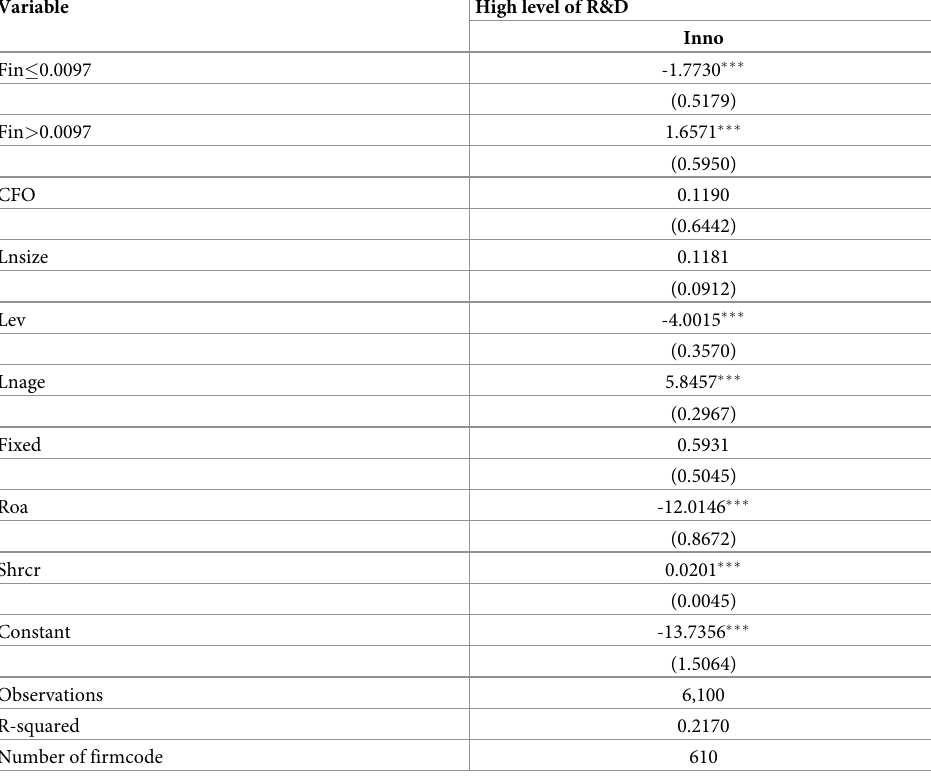
adopted to conduct parameter estimation in Table 6. Table 6. Regression result of threshold effect of enterprises with high R&D